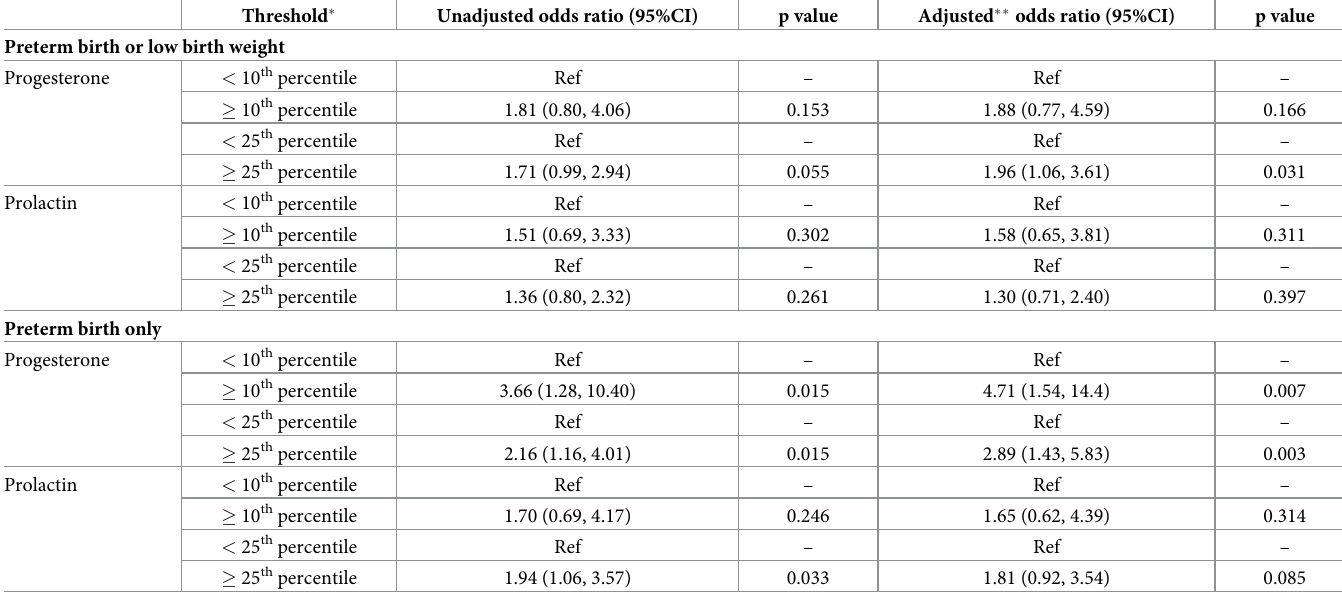
Table 3. Relationship of hormone level and odds of adverse birth